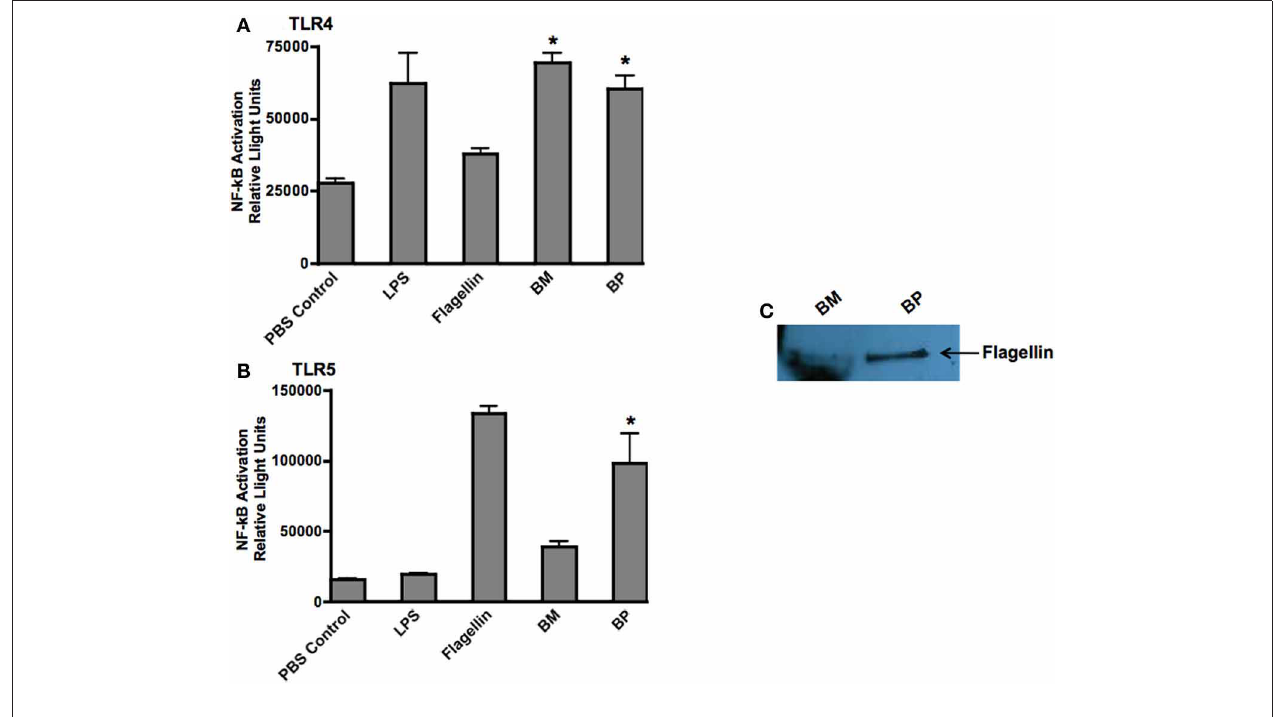
FIGURE 4 | BM and BP stimulation of various Toll-Like Receptors. To determine if BM and/or BP stimulated various TLRs, HEK293 cells expressing TLRs 4 and 5 and transfected with the firefly luciferase plasmid pNiFty2-Luc were stimulated with BM or BP at an MOI of 100:1. Un-stimulated cells served as negative controls. The TLR agonist served as positive controls. The cells were incubated with live bacteria for 6h. The medium was then aspirated and replaced with fresh DMEM without antibiotics and incubated overnight at 37 ◦ C and 5% CO 2 . The